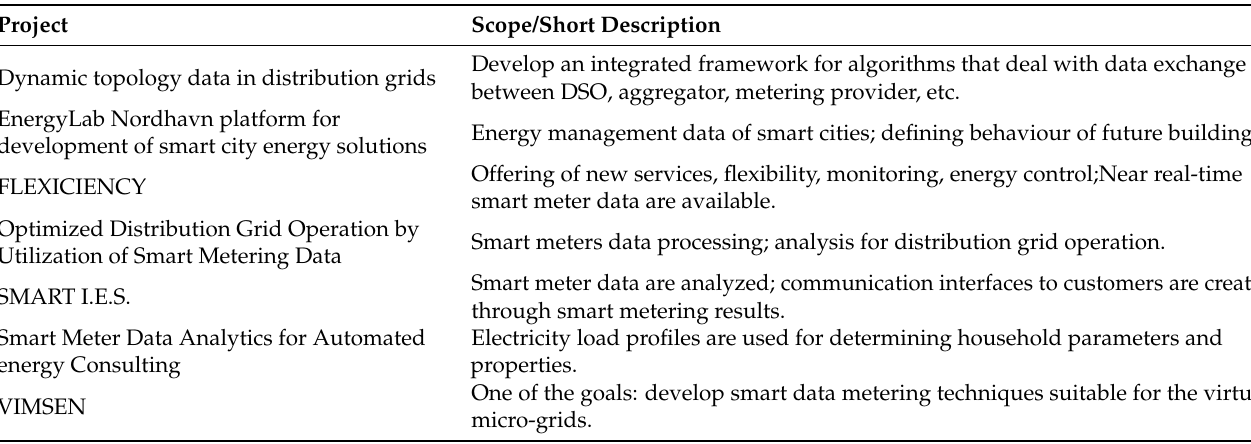
Table 9. Data management.